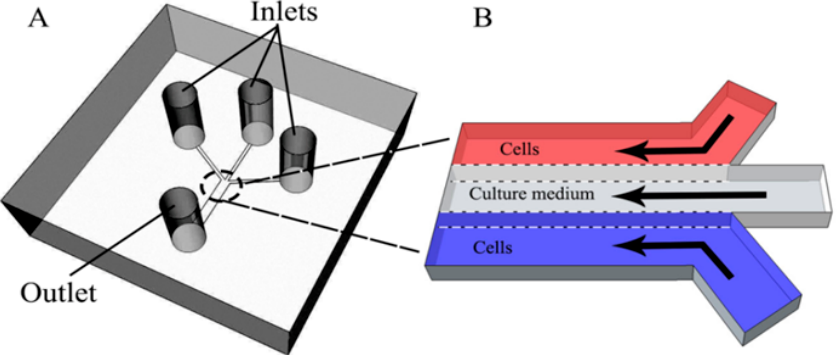
Figure 1. Schematic of the microfluidic platform employed for cell co-culture. ( A ) Diagram of the microfluidic device with three branching microchannels and one main microchannel. ( B ) Three parallel flows underway on the microfluidic platform.